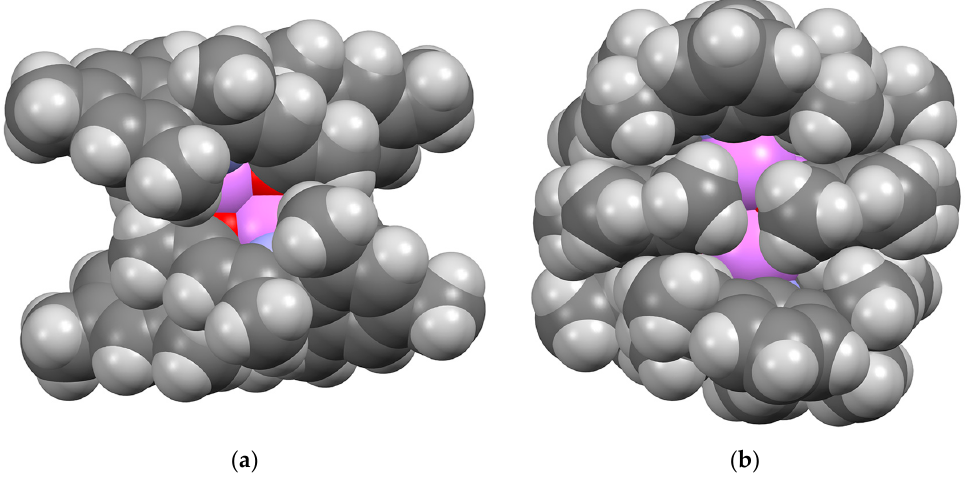
Figure A2. Space-filling depictions of the cuboidal Li 4 O 4 ketoiminate clusters ( a ) 3b and ( b ) 3c , emphasizing the globular nature of the latter and the more angular and clefted nature of the former.